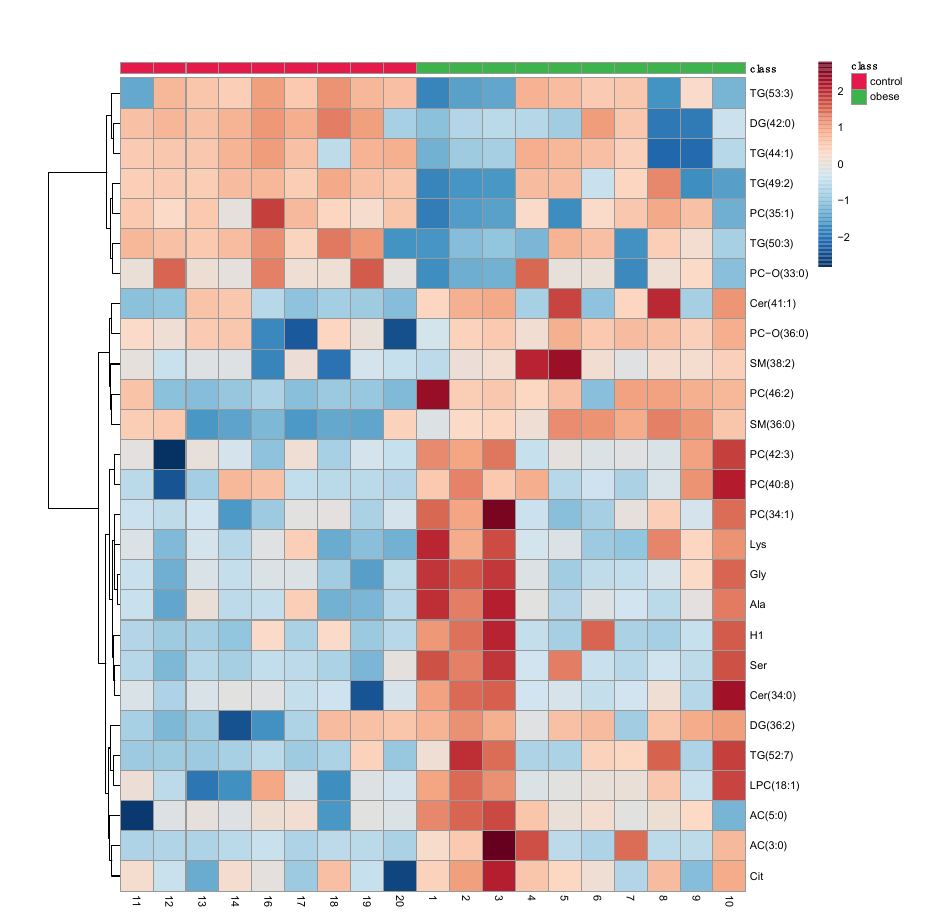
Figure 3. Hierarchical clustering differentiation of the 27 discriminative metabolites in obese and control dogs. Horizontal columns: relative concentration of each biologically relevant metabolite displaying distinct metabolic patterns between obese and control dogs. Each bar in the horizontal columns represents the expression intensity, where red bands indicate upregulated metabolites and blue bands indicate downregulated metabolites in the two groups.